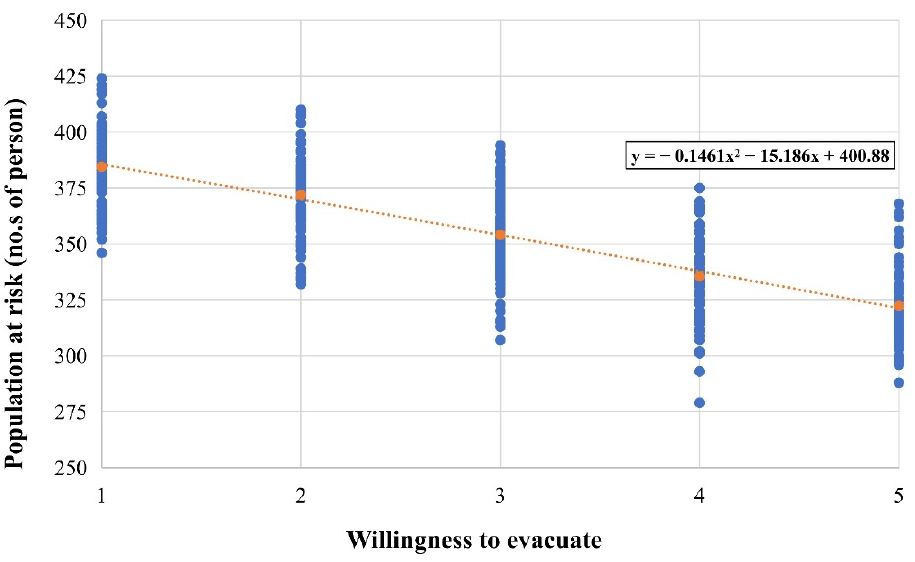
Figure 9. Correlation between willingness to evacuate and the population at